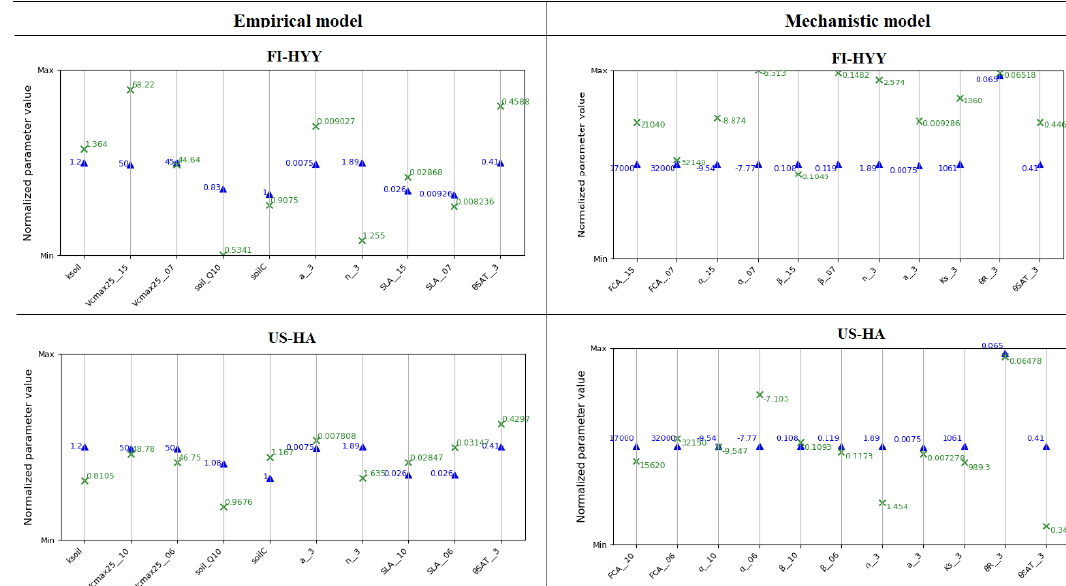
Figure E1. Comparison between prior and post-optimization parameter values at FI-HYY and US-HA. The y axis represents the nor- malization between the edges of the range of variation for each parameter. Prior values of the parameters are represented in blue, and post-optimization values are in